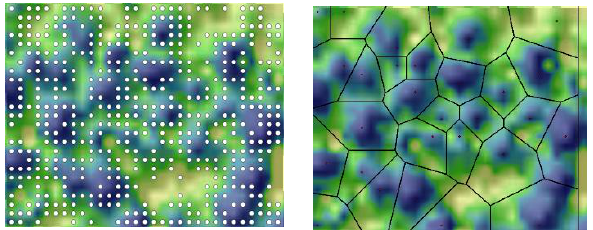
Figure 17. Negative profile curvature converted to points (left) and Thiessen polygons (right)